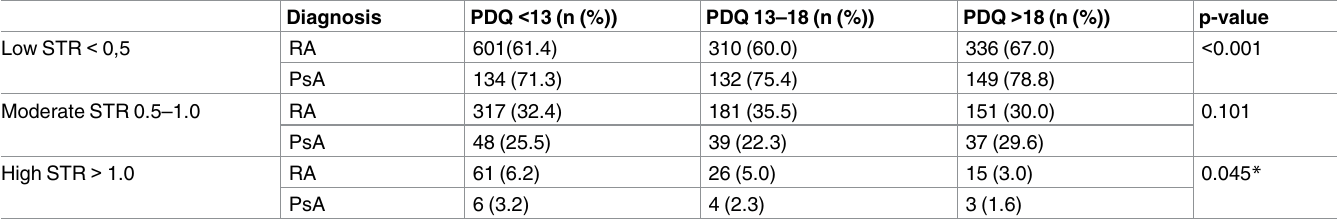
Table 3. Proportions n (%) of STR groups within PDQ classification-groups.